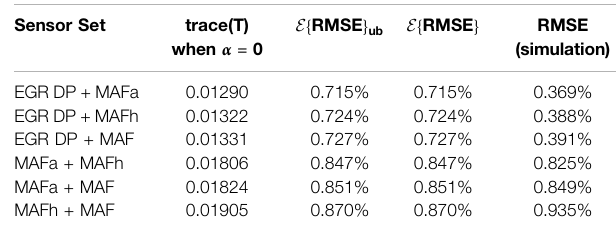
TABLE 7 | Two-sensor